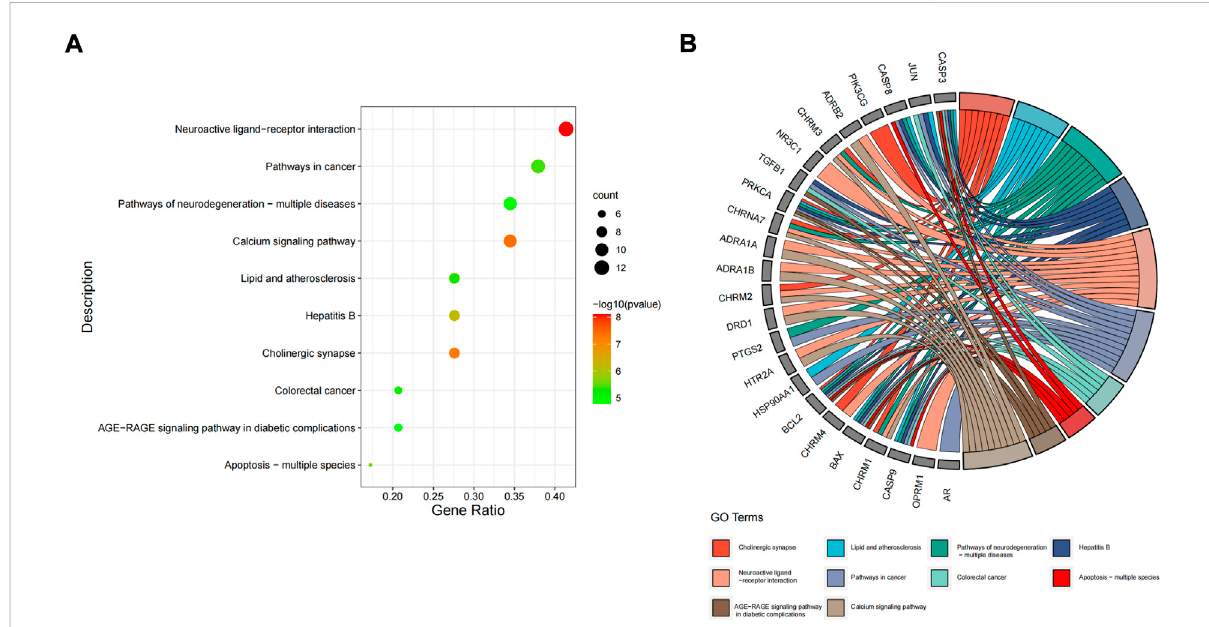
FIGURE 6 KEGG pathway enrichment analysis. The top 10 items ranked by − log10(p) value, gene count, and rich factor are shown by the bubble map (A) . The top 10 items ranked by − log10(p) value is shown by the Circro diagrams (B)